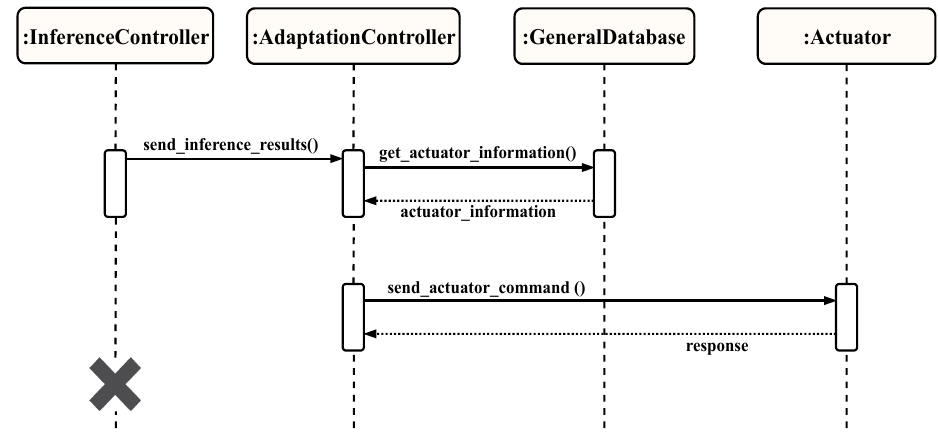
Figure 23. Output Step Database Interaction Sequence